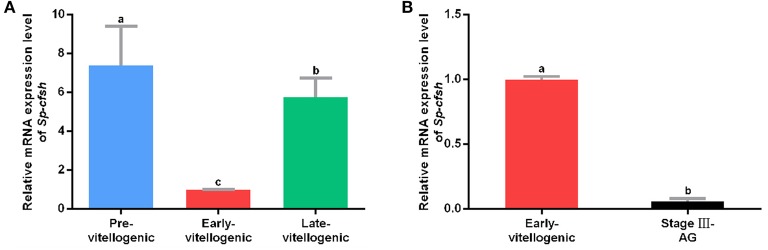
Quantitative analysis of Sp-CFSH expression. (A) Expression of Sp-CFSH at different stages of ovarian development. (B) Expression of Sp-CFSH in two sexes. The eyestalk ganglion of females at pre-vitellogenic stage, early-vitellogenic stage, and late-vitellogenic stage are designated as Pre-vitellogenic, Early-vitellogenic, and Late-vitellogenic, respectively, and the eyestalk ganglion of males at stage III of AG development is designated as Stage III-AG. The data are presented as mean ± SEM (n = 6) with different letters indicating statistical significance at p < 0.05.